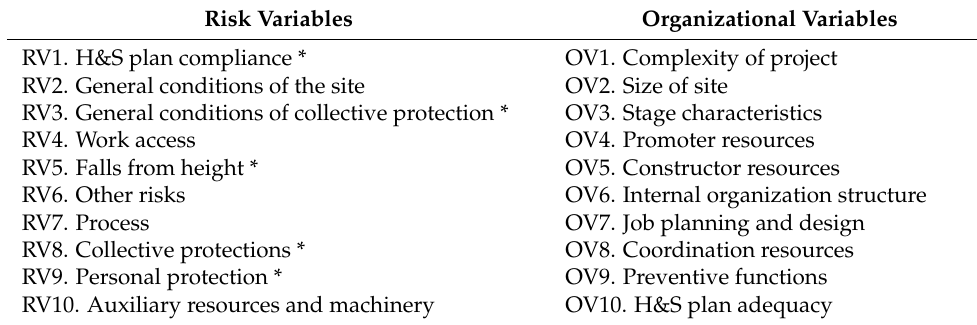
Table 1. The risk and organizational variables that comprise CONSRAT.